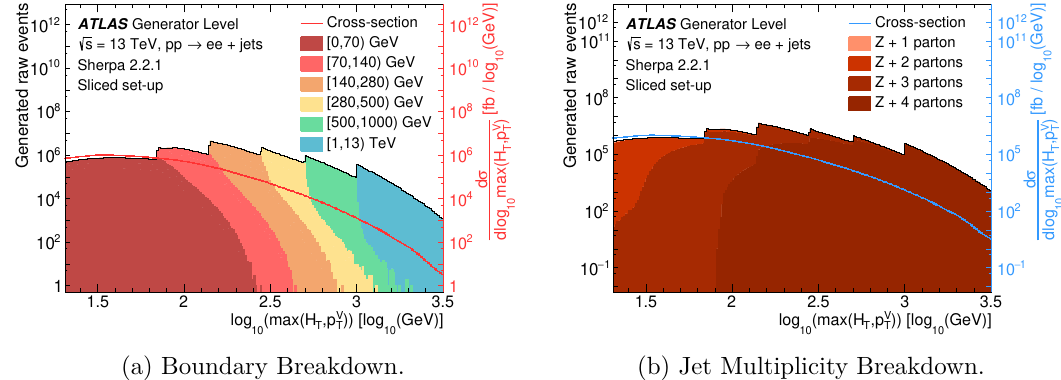
Figure 10 . Distribution of unweighted pp → e + e − + jets MC sampled events and differential cross-section for the sliced enhancement as a function of the slicing observable, log ( max ( H )) . , p V T T 10 Events are sliced according to the max ( H ) variable. The unweighted distribution is split either , p V T T (a) according to the phase-space sampling slices, or (b) according to the final-state jet multiplicity. In (b) the Z +1 parton contribution is small and only visible in the top left of the distribution. boundaries at max ( H ) = [70 , 140 , 280 , 500 , 1000] GeV, shown as coloured bands in fig- , p V T T ure 10(a), clearly illustrating the composite nature of the MC sample. The discontinuities in the unweighted event distribution at the integration boundaries are the result of gener- ating each phase-space slice with a different effective luminosity. Figure 10(b) contains the same information, split according to the final-state parton multiplicity, demonstrating that events with high parton multiplicity mostly populate the large-max ( H ) phase-space , p V T T